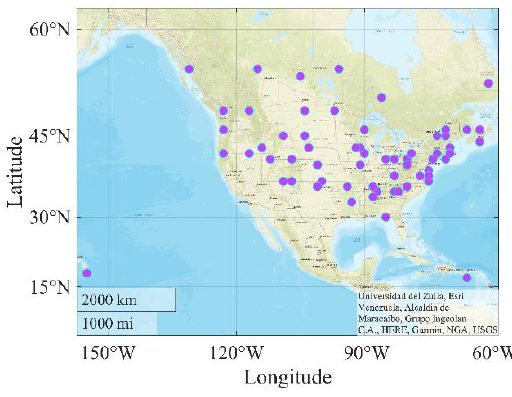
Figure 6. Distribution of data sources.